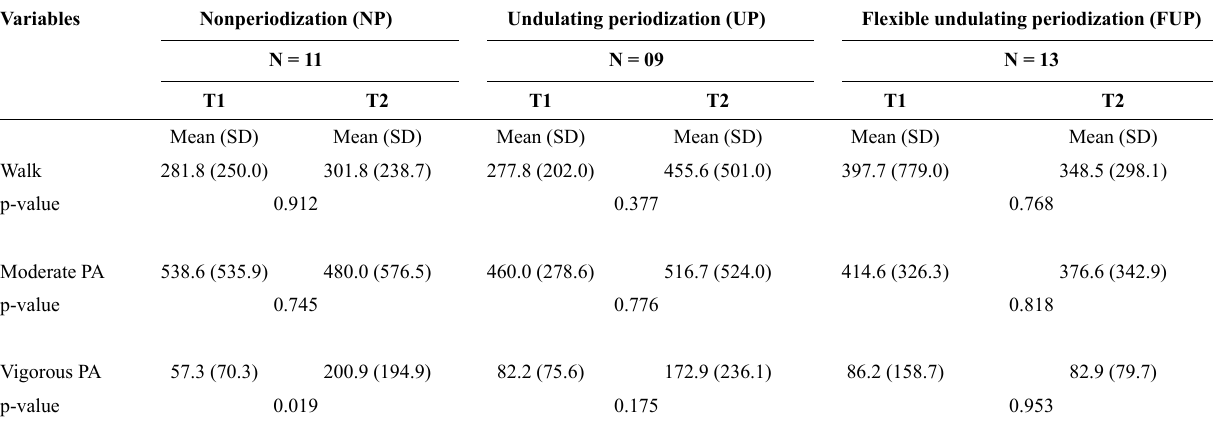
Table 6 - Distribution of the participants according to the min of physical activities performed per week as evaluated using the IPAQ-Short Form, by physical training group, and evaluation time.